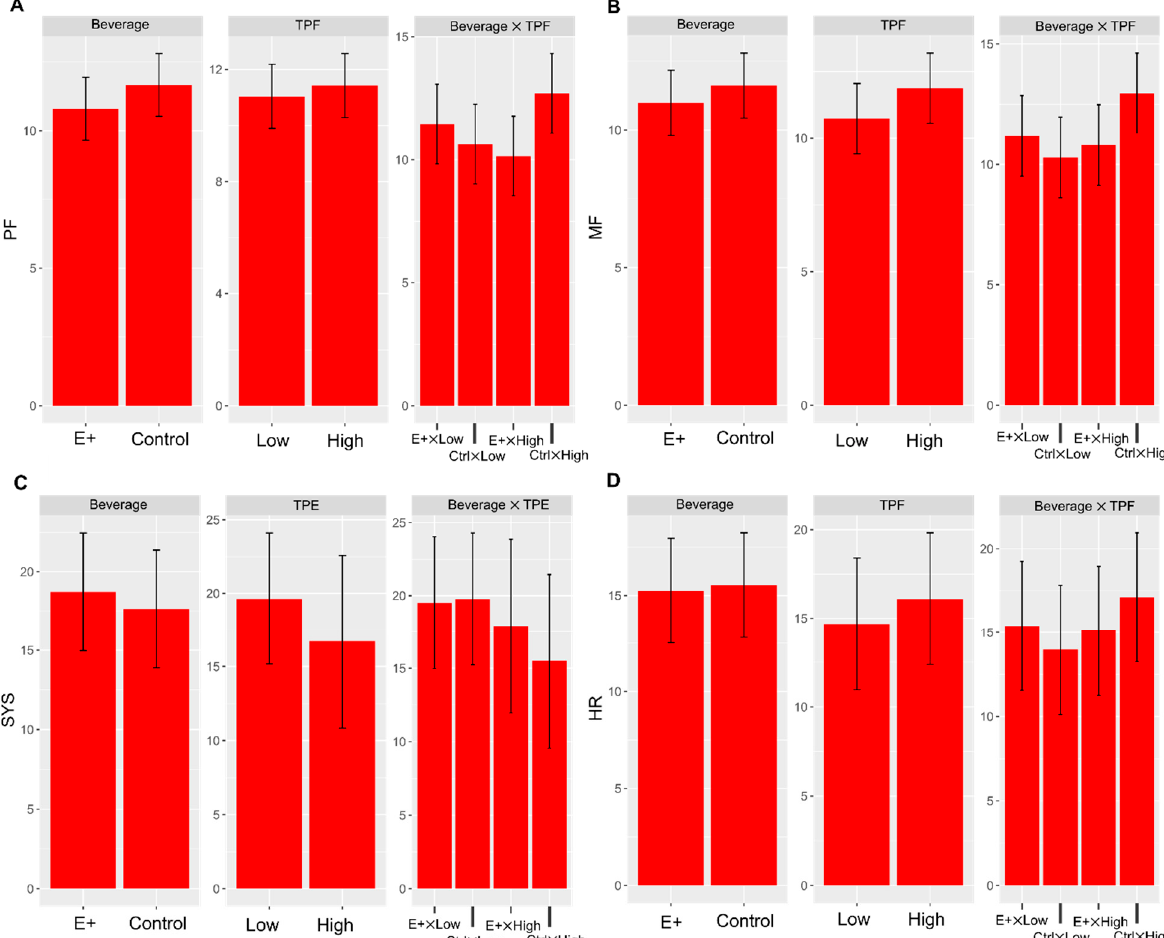
Figure 1. Marginal means over time and standard errors for each group for 4 different models. Both PF ( A ) and MF ( B ) are examples of higher-order interaction effects between beverage type and TPF. Similar interaction effects are shown for systolic blood pressure ( C ) and heart rate ( D ), related to TPE and TPF, respectively.